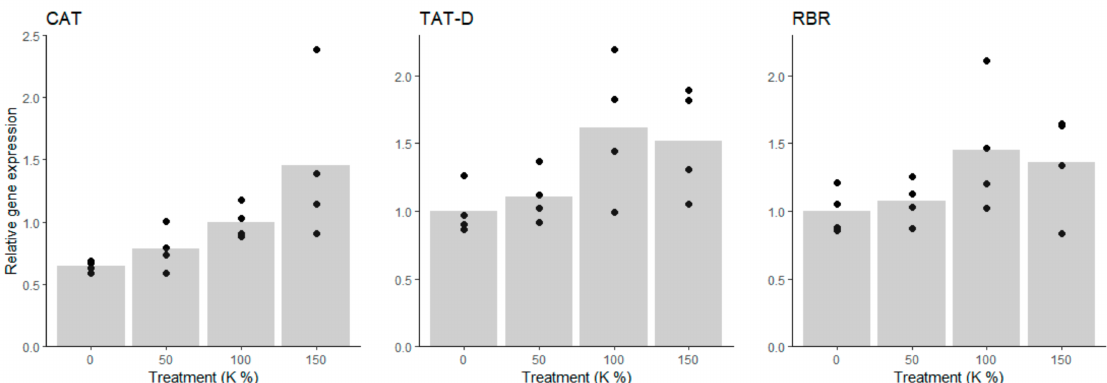
Figure 2. Expressions of oxidative stress-, PCD-, and cell cycle-related genes in Scots pine embryogenic cells under potassium (K) treatments. The expression of the catalase ( CAT ), Tat-D nuclease ( TAT-D ), and retinoblastoma-related protein ( RBR ) genes decreased under the 0% K treatment compared to the 100% K treatment.